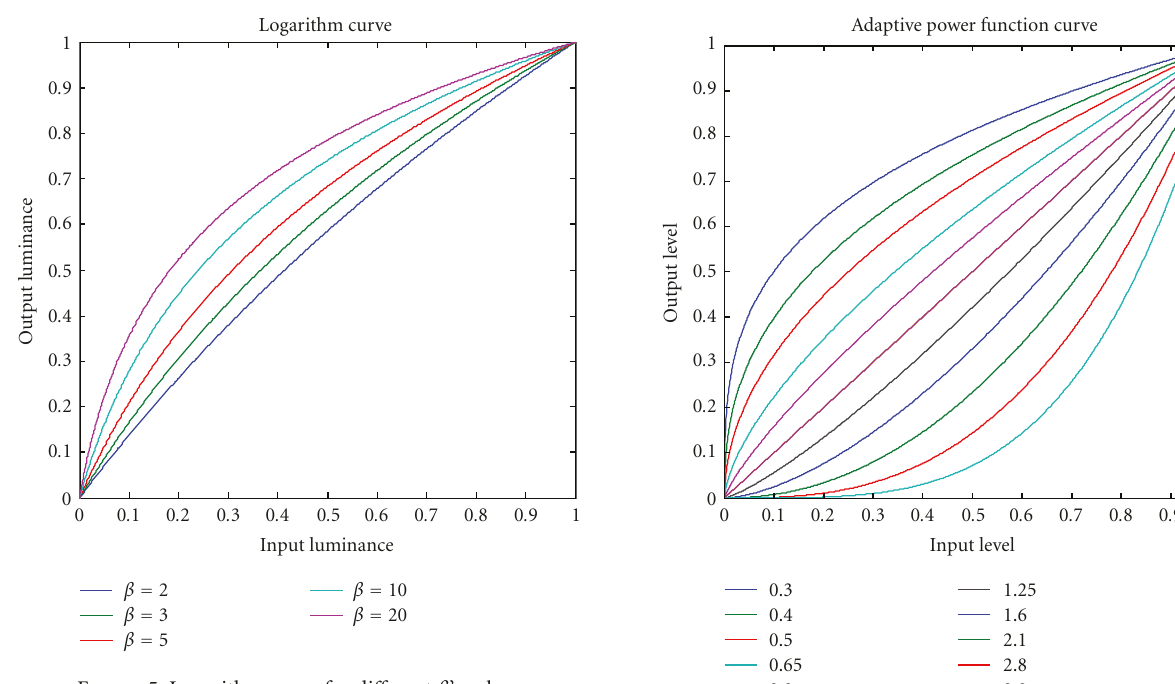
Figure 5: Logarithm curve for di ff erent β ’s value.